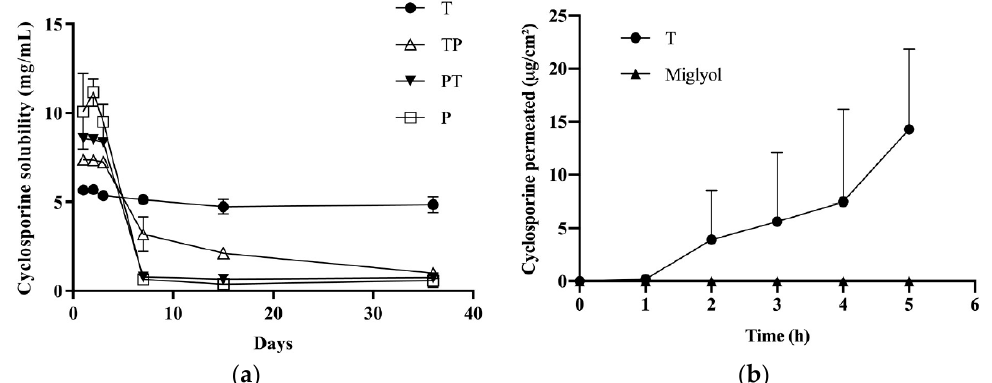
Figure 3. ( a ) Cyclosporine’s apparent solubility when incorporated in micelles of TPGS, poloxamer 407, and TPGS:poloxamer 407. ( b ) Transconjunctival permeation profile of cyclosporine from formulation T ( n = 4) and Miglyol ® solution (drug conc. = 5 mg/mL; n = 3).